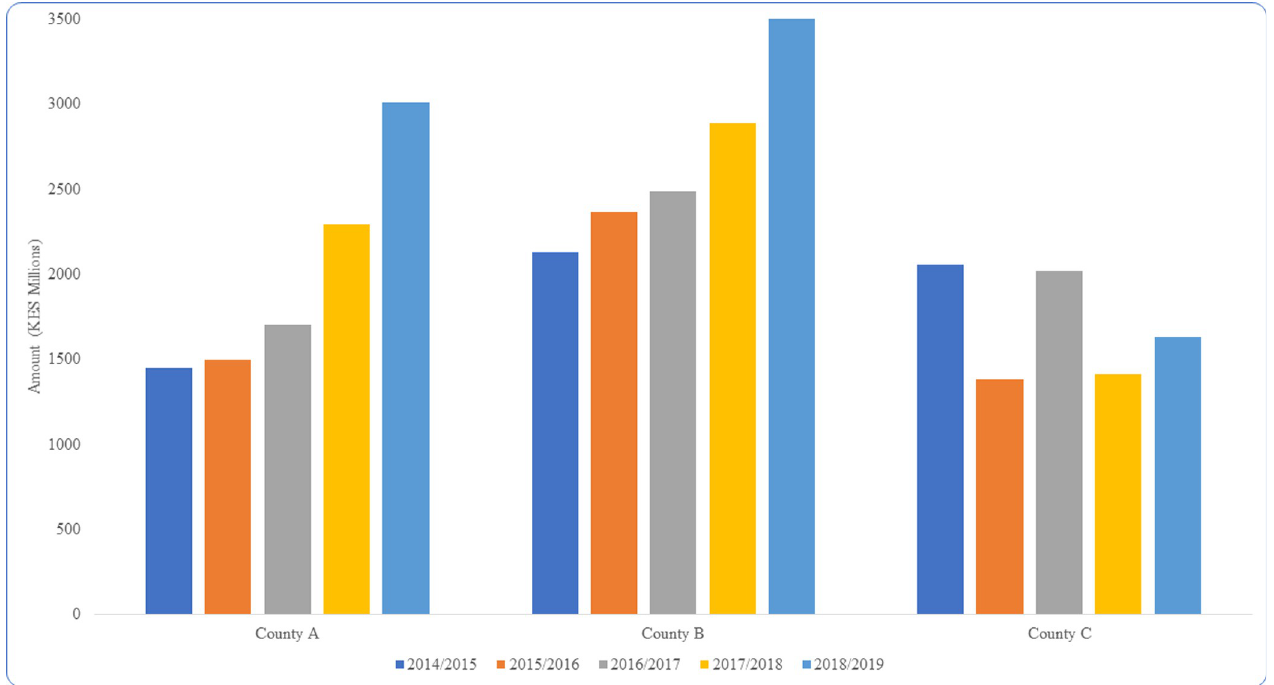
Fig 2. Trends for overall health sector budget allocation in study